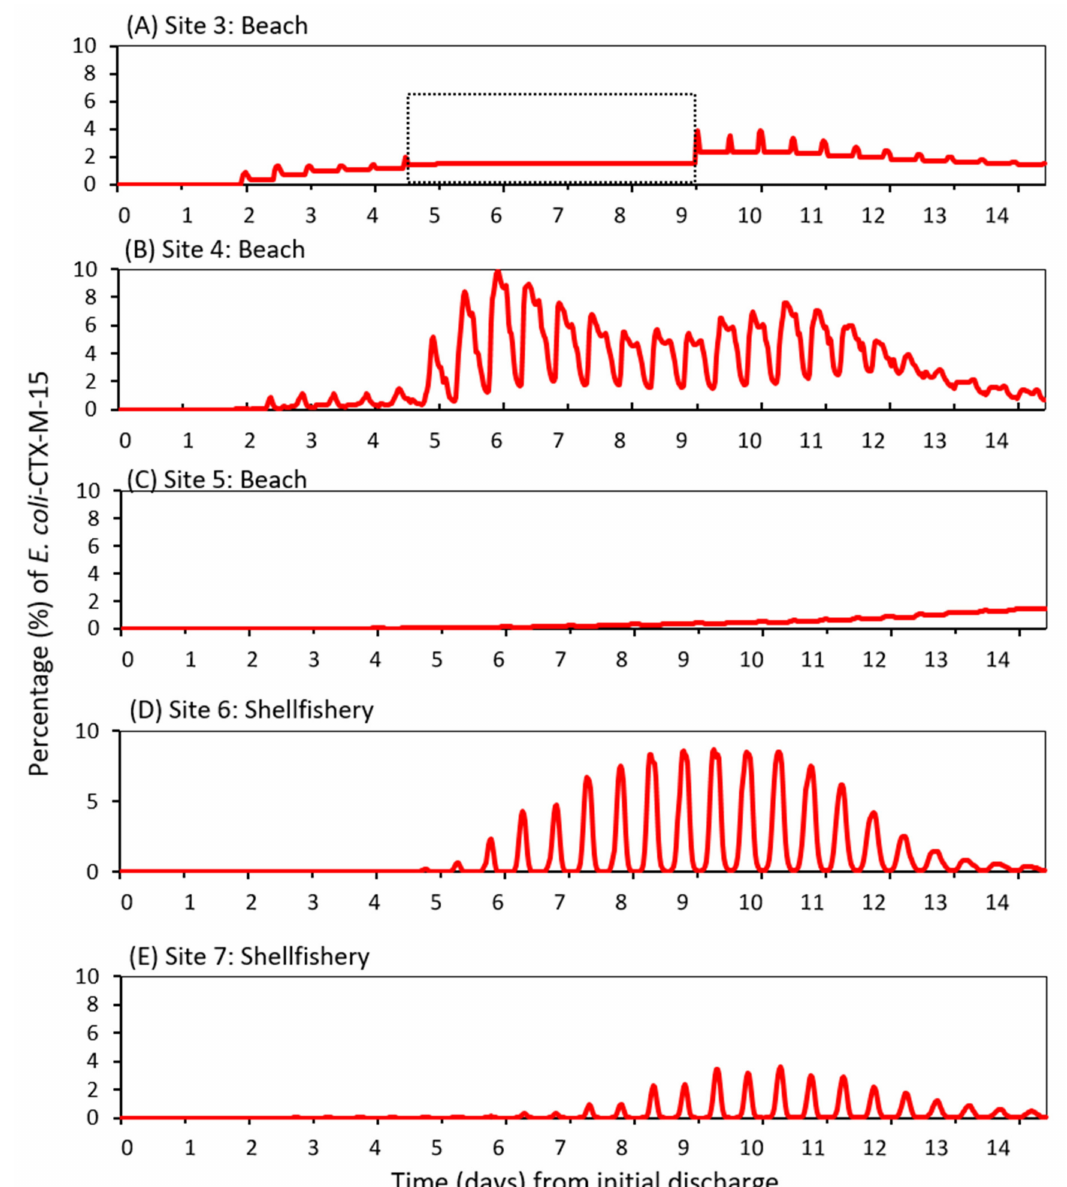
Figure 4. Simulated bla CTX-M-15 -producing E. coli at Sites 3–7 ( A – E ). The dashed square in ( A ) denotes a period of neap tides when Site 3 was dry and the simulated E. coli concentrations were